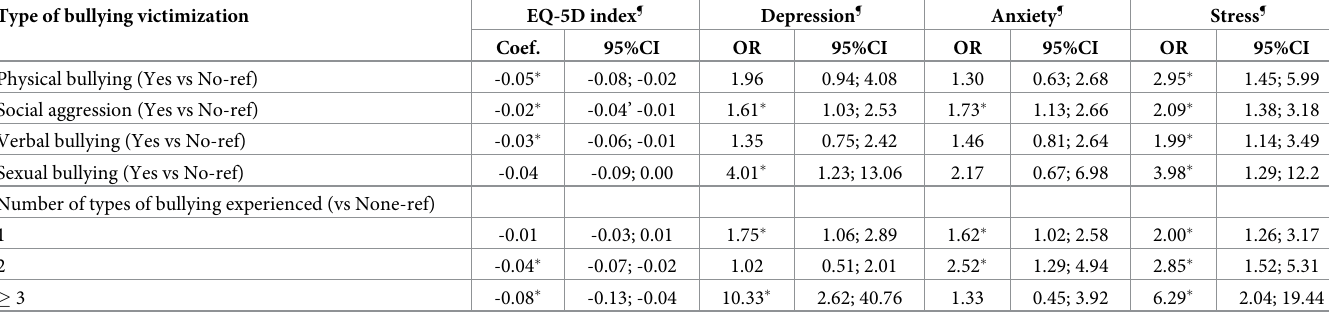
Table 6. Associations between bullying victimization and HRQOL and mental health impairment. Type of bullying